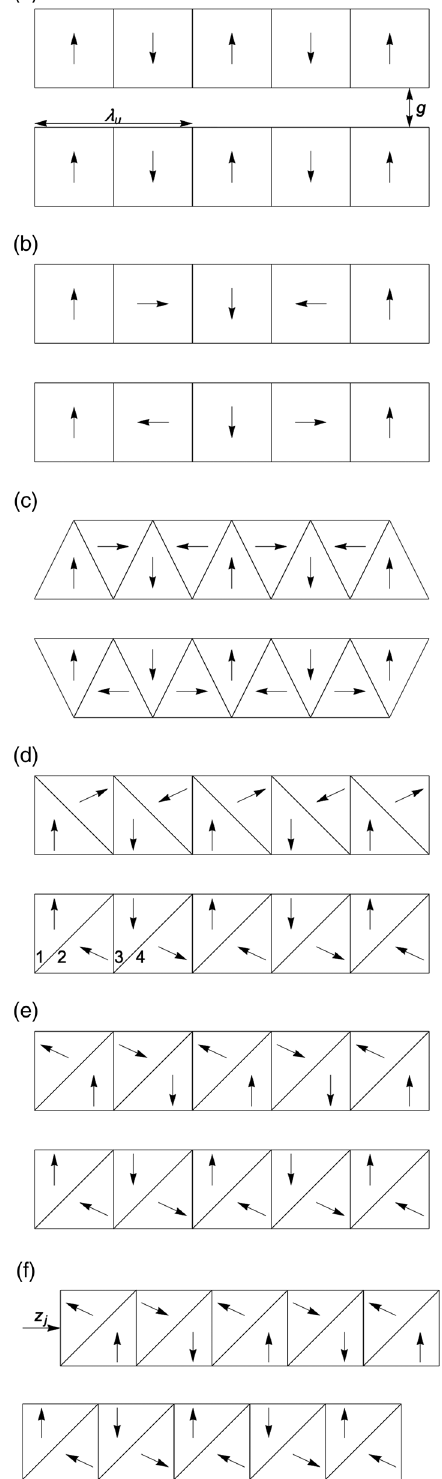
FIG. 2. Examples of the undulator configurations. (a) M 0 ¼ 2 array, (b) M 0 ¼ 4 array, (c) isosceles triangles, (d) reflection symmetric right triangles, (e) rotationally symmetric right trian- gles, and (f) rotationally symmetric right triangles with jaw translation (positive z is illustrated but negative is typically j